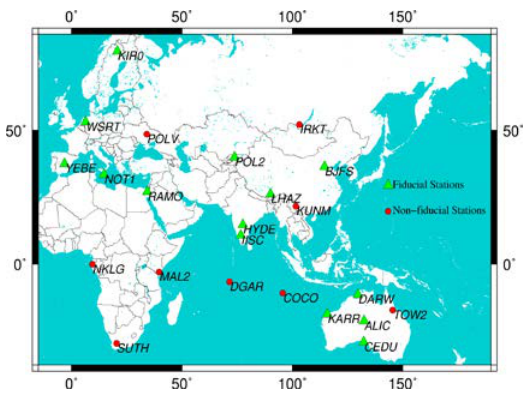
Figure 1. Fiducial and non-fiducial IGS stations selected for Bernese processing